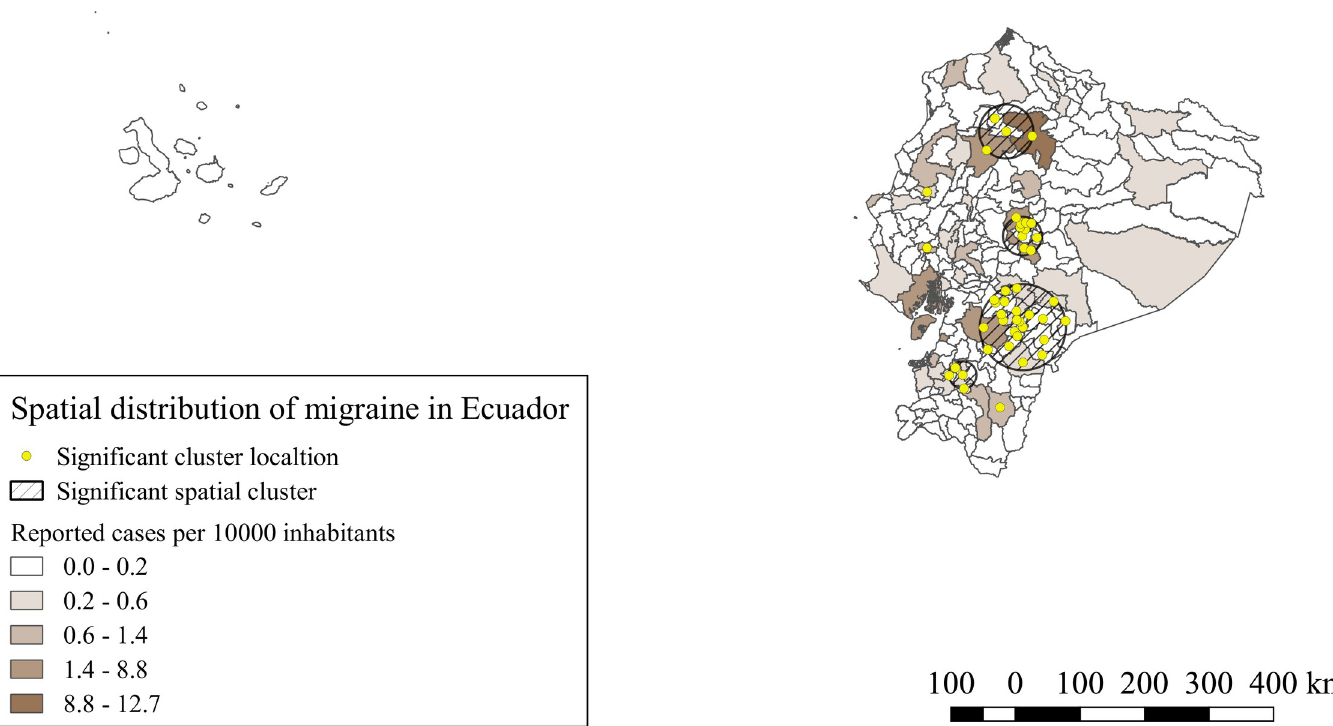
Fig 4. Spatial distribution and significant space clusters of migraine hospitalized cases in Ecuador. Shape files for this map were obtained from INEC portal [51].